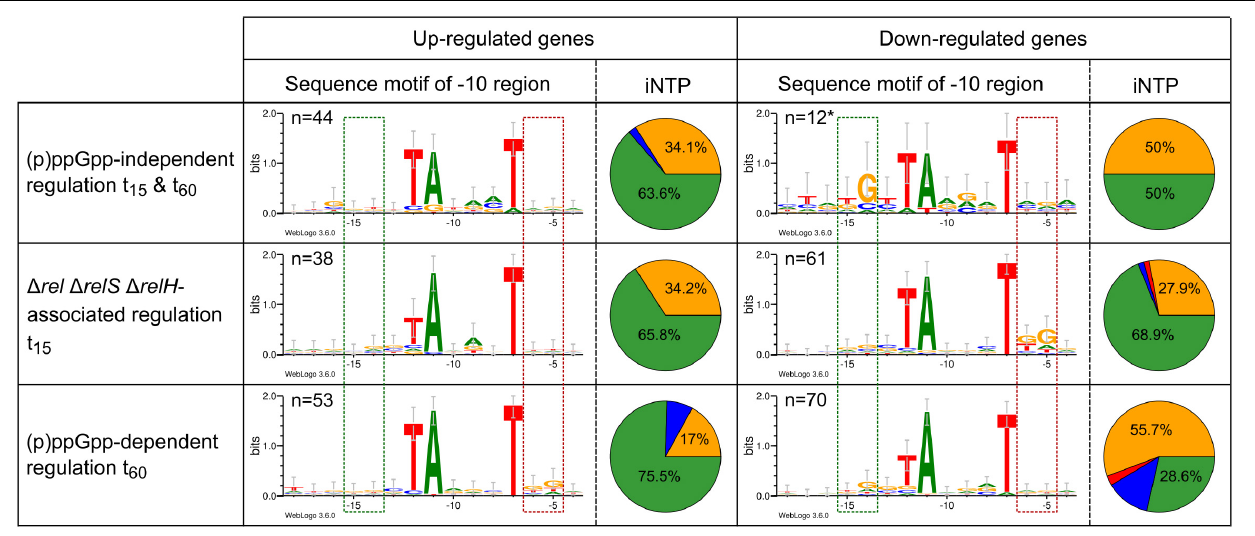
FIGURE 8 | Initial NTP (iNTP) distribution and sequence logos of the − 10 motif within selected differentially regulated groups of total starvation analysis between wild type strain CR099 and (p)ppGpp-devoid mutant (cid:49) rel (cid:49) relS (cid:49) relH . The percentage composition of the nucleic acid at position +1 (iNTP) is shown in the form of a pie chart: green: ATP; red: UTP; blue: CTP; yellow: GTP. The − 10 motif was identified using Improbizer (Ao et al., 2004) and the corresponding sequence was displayed with Weblogo3 (Crooks et al., 2004) as sequence logo from position − 18 to − 4. The stack height corresponds to the sequence conservation, measured in bits, and the height of each letter corresponds to the relative frequency of the corresponding nucleic acid at that position. The green box corresponds to the localization of the extended − 10 motif (Barne et al., 1997) and the red box illustrates to the position of the − 10 motif extension, which has been identified for σ B dependent promoters (Ehira et al., 2008) ∗ Since no Improbizer -motif of the − 10 region was found by Improbizer due to the small number of samples, the predicted − 10 motif localizations of the original data were used (Pfeifer-Sancar et al., 2013; Albersmeier et al.,